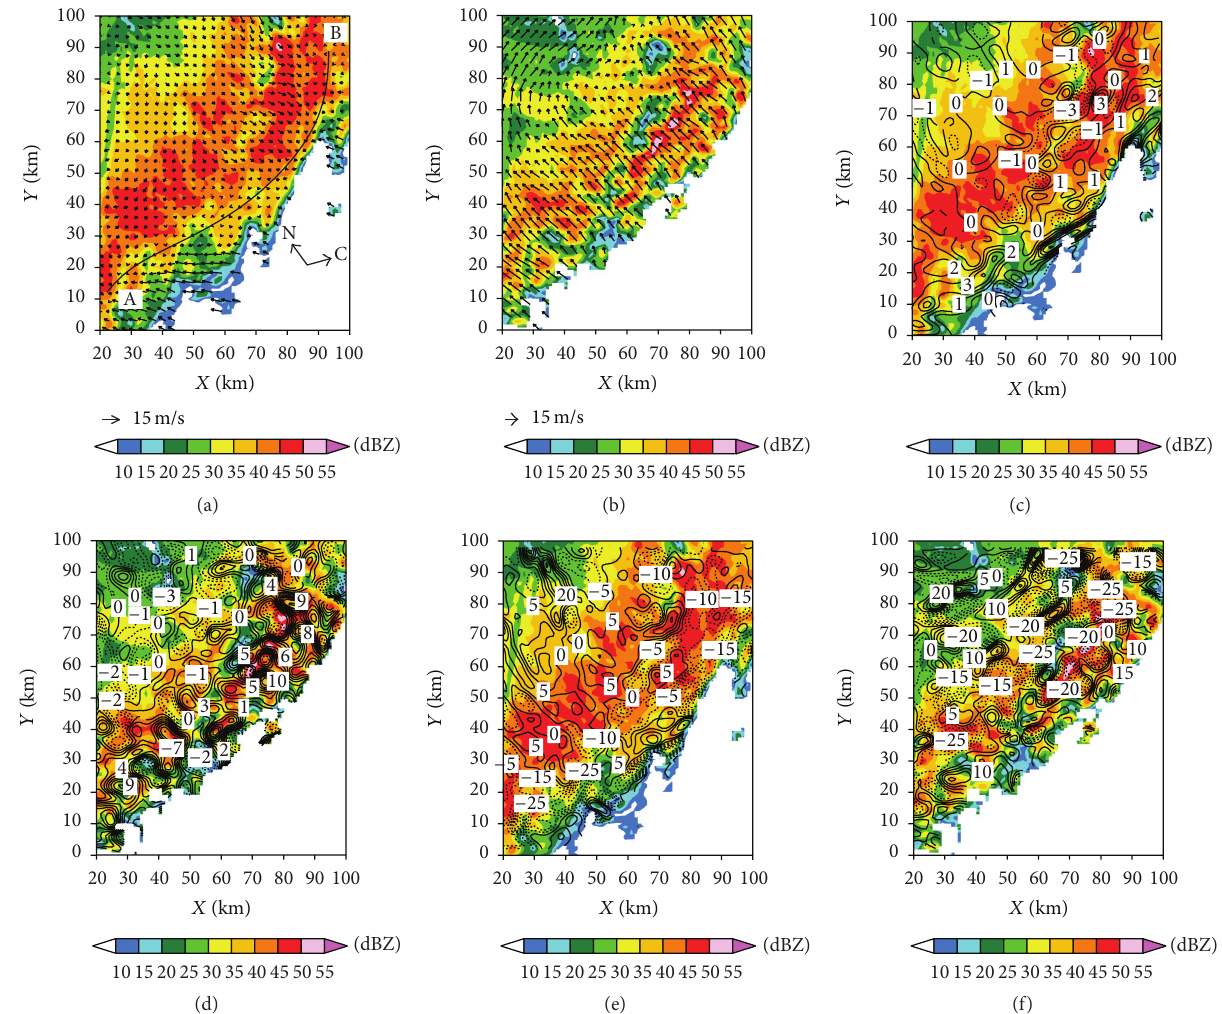
Figure 9: (a-b) The storm-relative horizontal wind fields at 1.75 and 5 km, respectively, at 1005 LST 24 April 2007. (c-d) The vertical velocities at 1.75 and 5 km, respectively. The solid lines indicate the updraft and the dashed lines for the downdraft. (e-f) The divergence field (10 −4 s −1 ) at 1.75 and 5 km, respectively. Solid lines are for positive values (divergence) and dashed lines for negative value (convergence); the contour interval is 5 × 10 −4 s −1 . The 𝑥 -axis and 𝑦 -axis are, respectively, parallel and perpendicular to the radar baseline. The colour shading is radar reflectivity (dBZ). The squall line movement direction (C) and the north (N) are indicated in (a). Line AB in (a) denotes the convergence